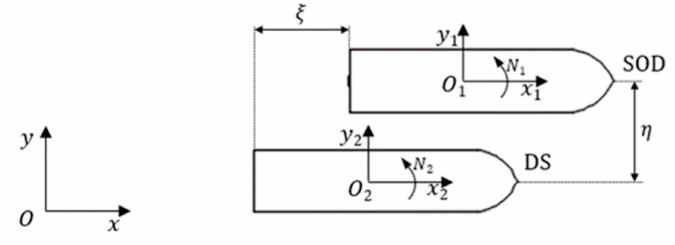
Figure 1. Coordinate system